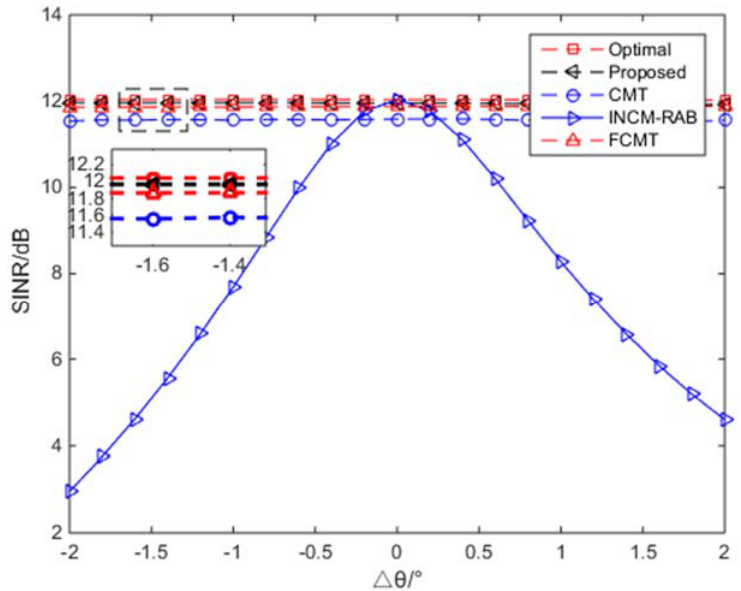
Figure 5. Relationship between output SINR and the interference mismatch angle.